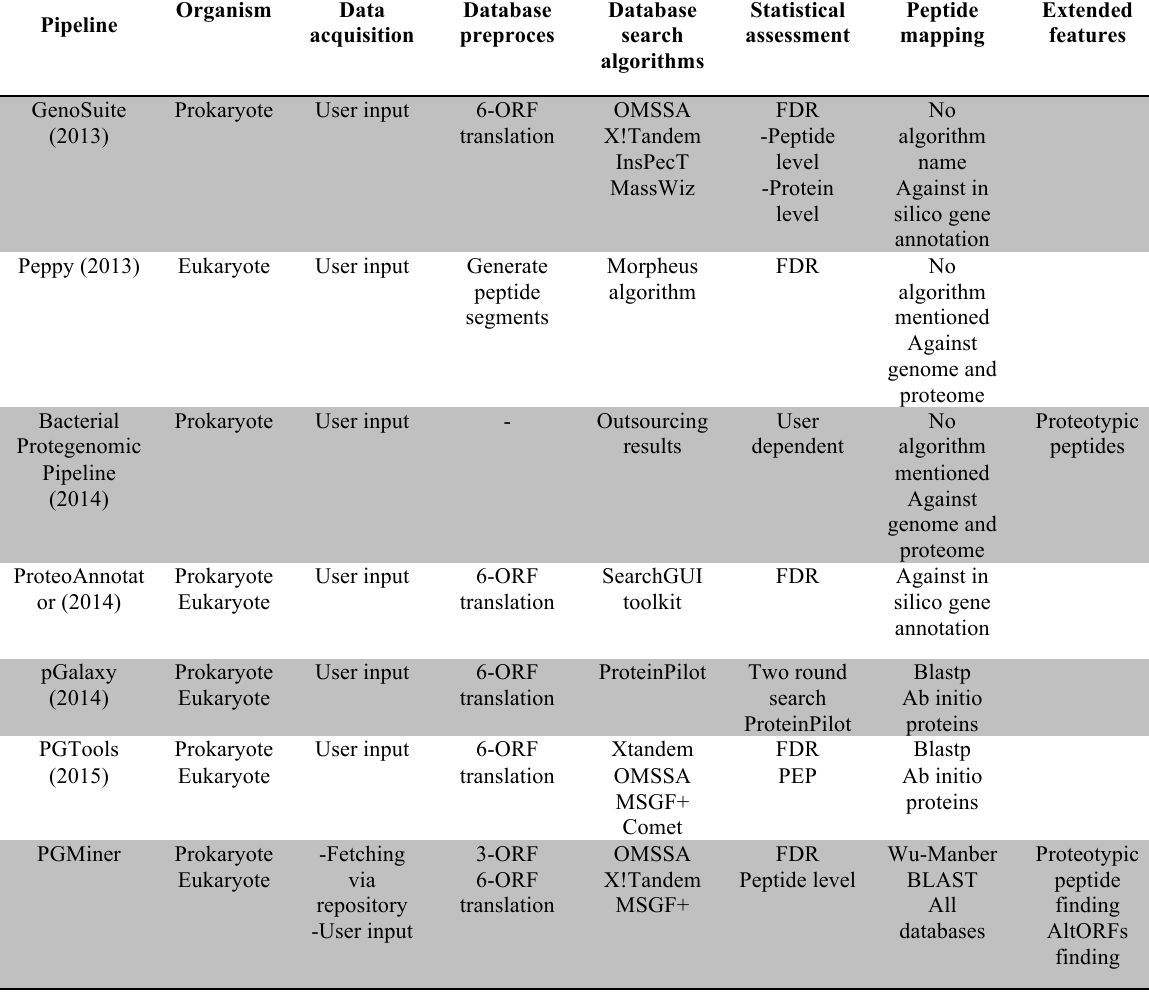
Table 1 Comparison of proteogenomics tools are listed in terms of general proteogenomic workflow steps.